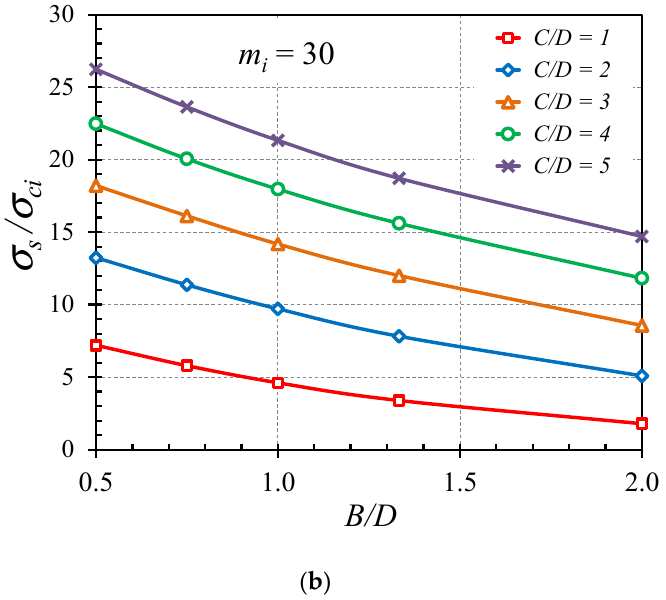
Figure 8. Impact of B / D on σ s / σ ci of horseshoe tunnels with σ ci / γ D = 1000 and GSI = 80: ( a ) m i = 5 and ( b ) m i = 30.